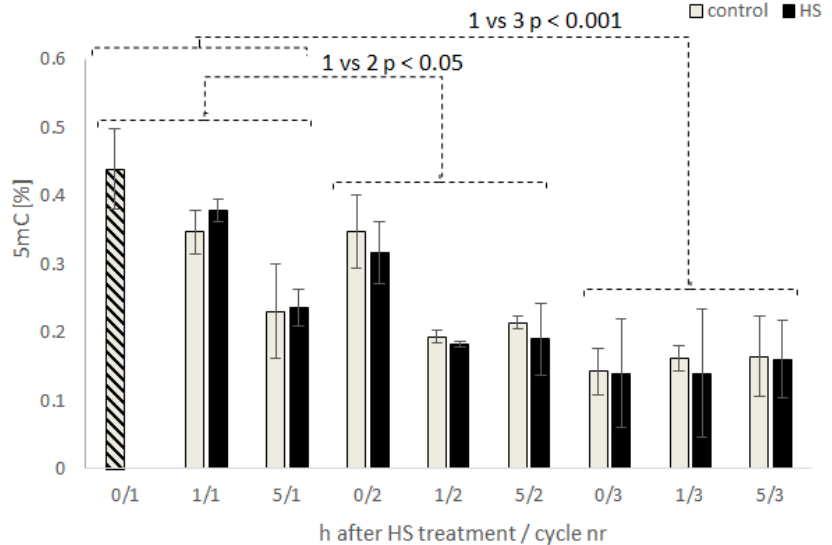
Figure 2. Level of global DNA methylation (5 mC) in Y. lipolytica W29 strain cultivated in repeated-batch cultures, under HS (grey) and control (black) conditions. Sample names are encoded: hours after HS/number of cycles. Error bars indicate the ±SD from biological triplicate, each analyzed in technical triplicate.